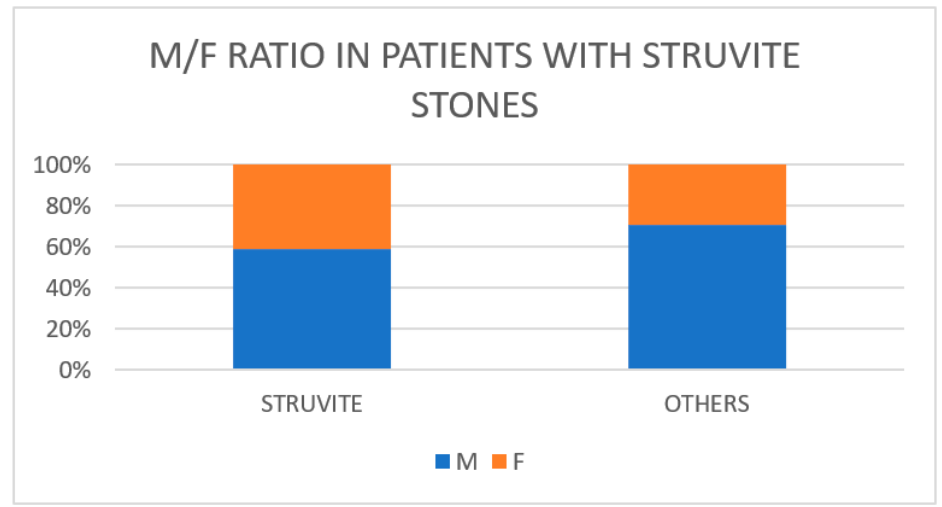
Figure 1. Male-to-female ratio of patients with struvite stones.